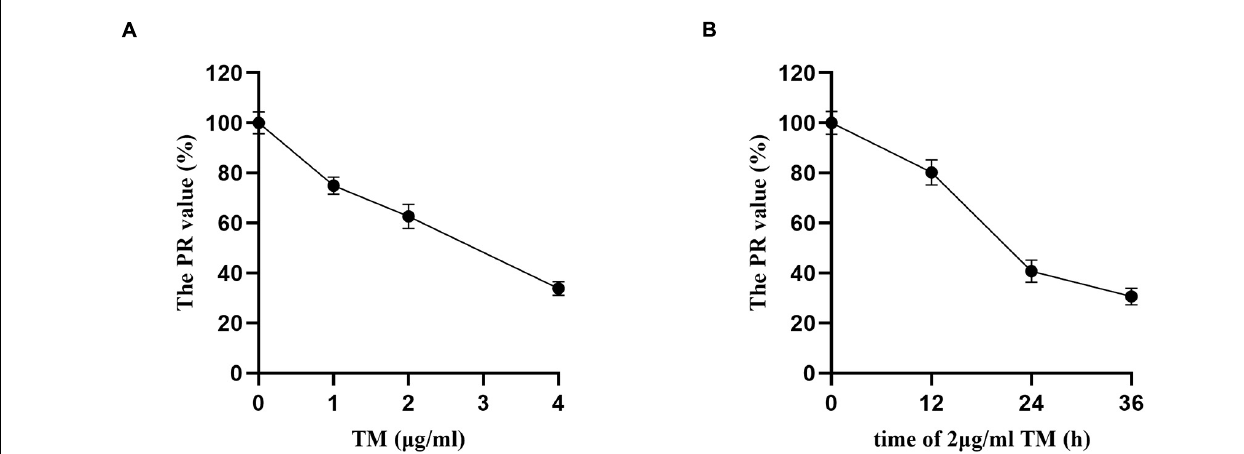
FIGURE 1 | Tunicamycin concentration and treatment time screening by MTT. After the HSCs were treated by TM with different concentrations and treatment time, the OD value of each treatment was assayed, and the proliferation rate (PR) of HSCs was calculated. (A) HSCs were treated with various concentrations of TM for